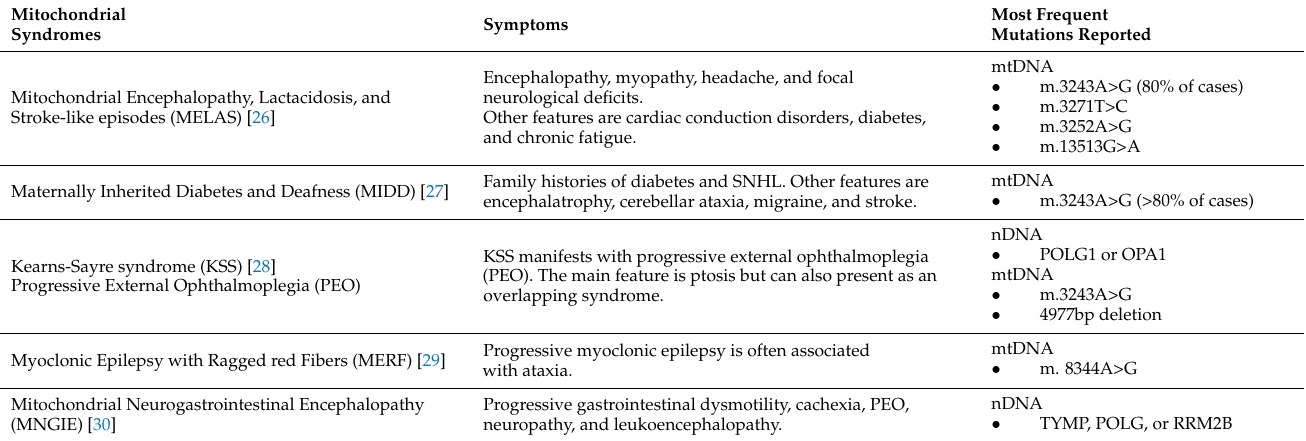
Figure 3. The phenotypes commonly associated with hearing loss in the current review [21,23–25]. All numbers in the figure are expressed as percentages. Table 3. The systemic manifestations and genetic correlation of main PMDs. POLG (DNA polymerase subunit gamma), OPA (optic atrophy), TYMP (thymidine phosphorylase), RRM2B (Ribonucleotide- diphosphate reductase subunit M2